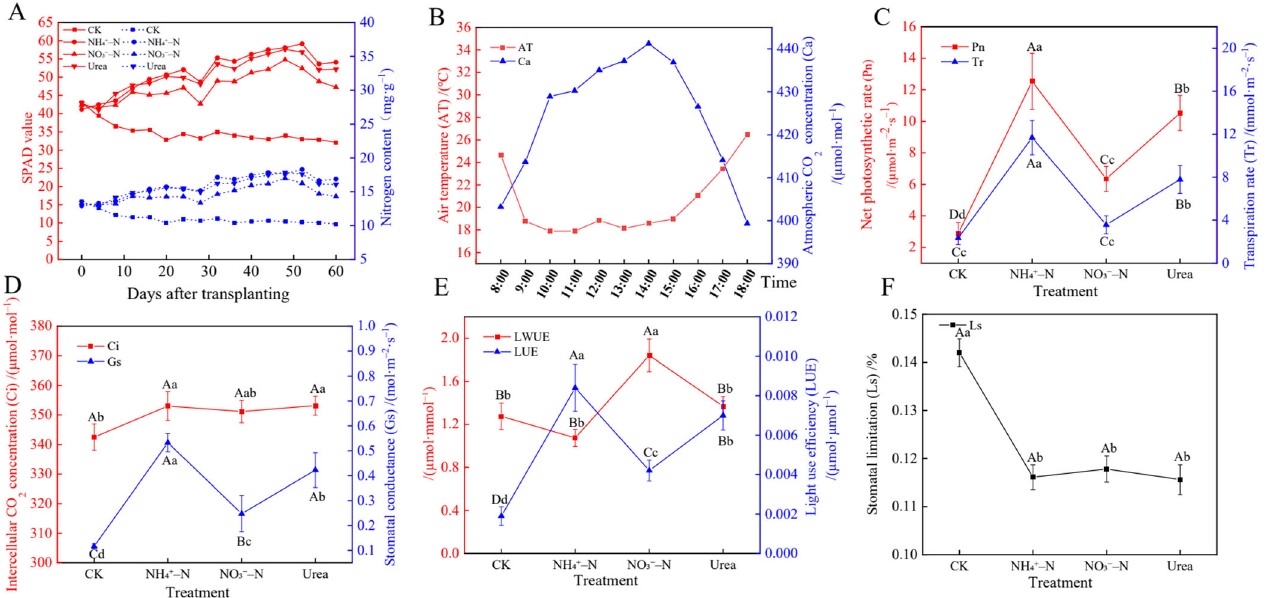
Figure 4. Effects of different N forms on the leaf photosynthetic parameters of blackberry. Changes in the relative chlorophyll content (SPAD value) and N content with time ( A ). Changes in air temperature (AT) and atmospheric CO 2 concentration (Ca) during the day ( B ). Effects of different N forms on the net photosynthetic rate (Pn) and transpiration rate (Tr) ( C ), intercellular CO 2 concentration (Ci) and stomatal conductance (Gs) ( D ), leaf water use efficiency (LWUE) and light use efficiency (LUE) ( E ) and stomatal limitation (Ls) ( F ). The data indicated are the means ± SDs ( n = 20). Different letters show significant differences between treatments (uppercase letters indicate p < 0.01, lowercase letters indicate p < 0.05).